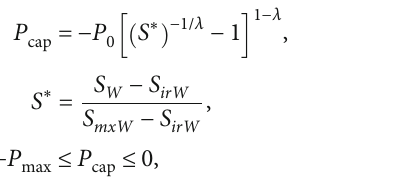
Figure 4: Evolution of the gas saturation distribution S = 0 : 05 , and P = 0 : 1MPa S 0 irG